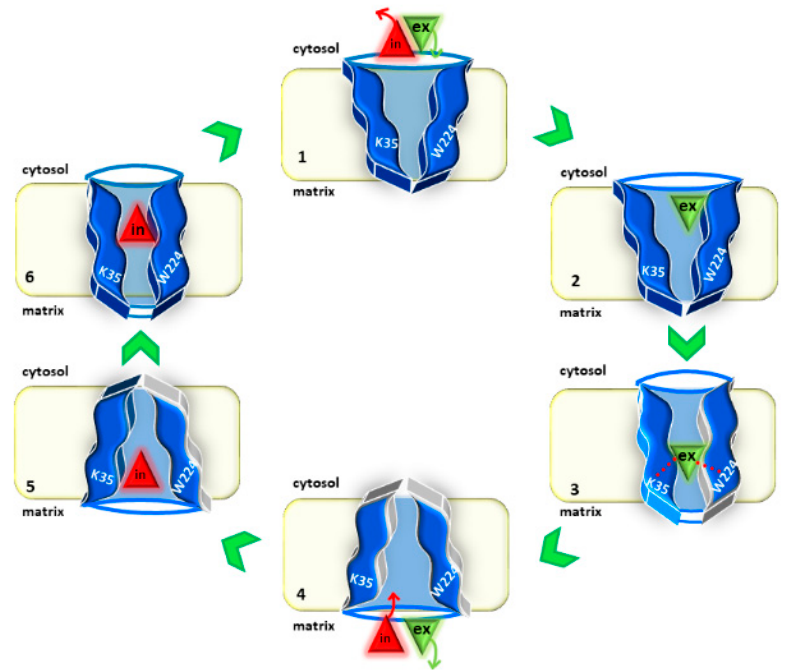
Figure 6. Sketch of the transport cycle of CAC. The states of the transporter during the antiport reaction are displayed: (1) c-state in the absence of substrate, (2) c-state with the external substrate entering the carrier, (3) occluded state or transition state with the external substrate bound to the substrate-binding site, (4) m-state in the absence of substrate, (5) m-state with the internal substrate entering the carrier, (6) occluded state or transition state with the internal substrate bound to the substrate-binding site. The role of K35 and W224 during the transport cycle is highlighted with dotted lines.